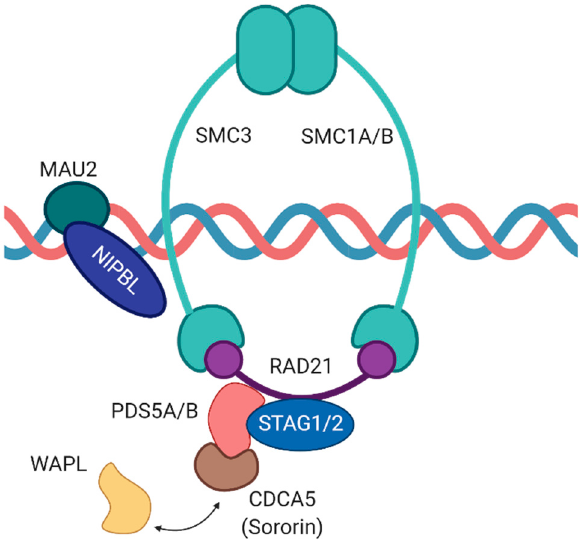
Figure 1. Overview of the cohesin complex and its associated proteins. Four proteins (SMC1, SMC3, RAD21, STAG) constitute the core and form a large ring to encircle DNA strands. The NIPBL/MAU2 heterodimer loads cohesin onto DNA, whereas WAPL/PDS5 release cohesin from chromosomes. CDC5A competes with WAPL for binding to PDS5.